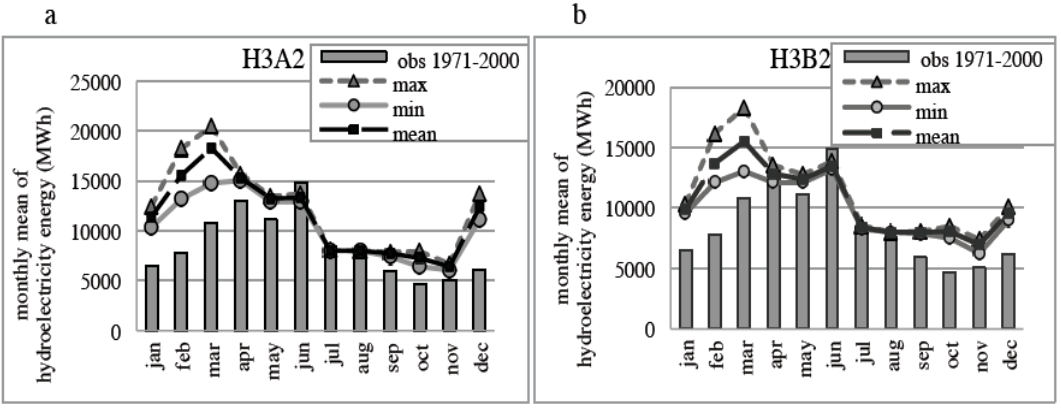
Figure 10. Range of monthly simulated hydropower energy under ( a ) A2 and ( b ) B2 emission scenarios in the 2020–2049 (near future).